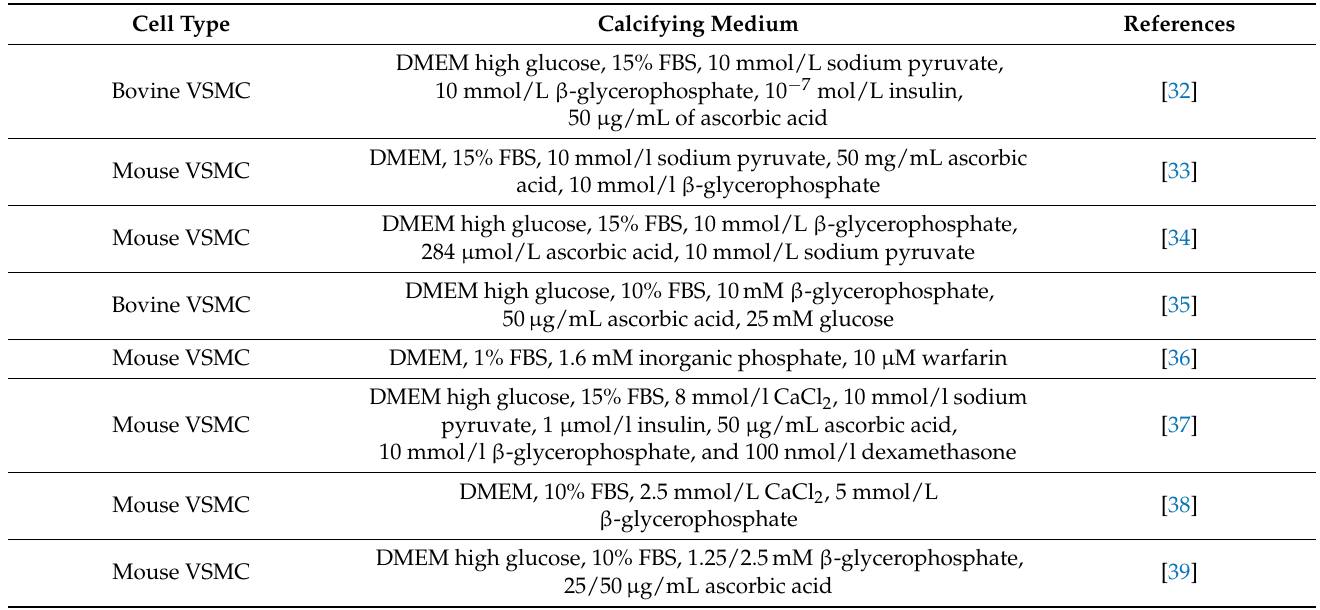
Table 1. Experimental conditions for inducing calcification in in vitro